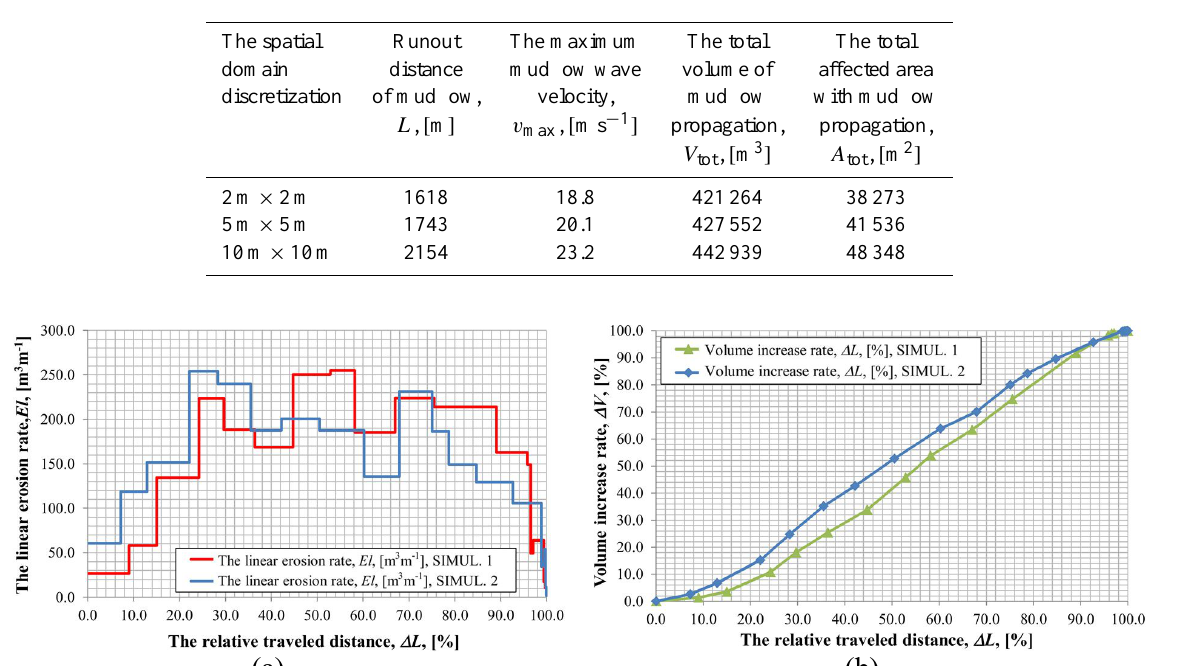
Table 2. The impact of spatial domain discretization on output parameters of mudflow propagation with the application of the Egashira erosion law.